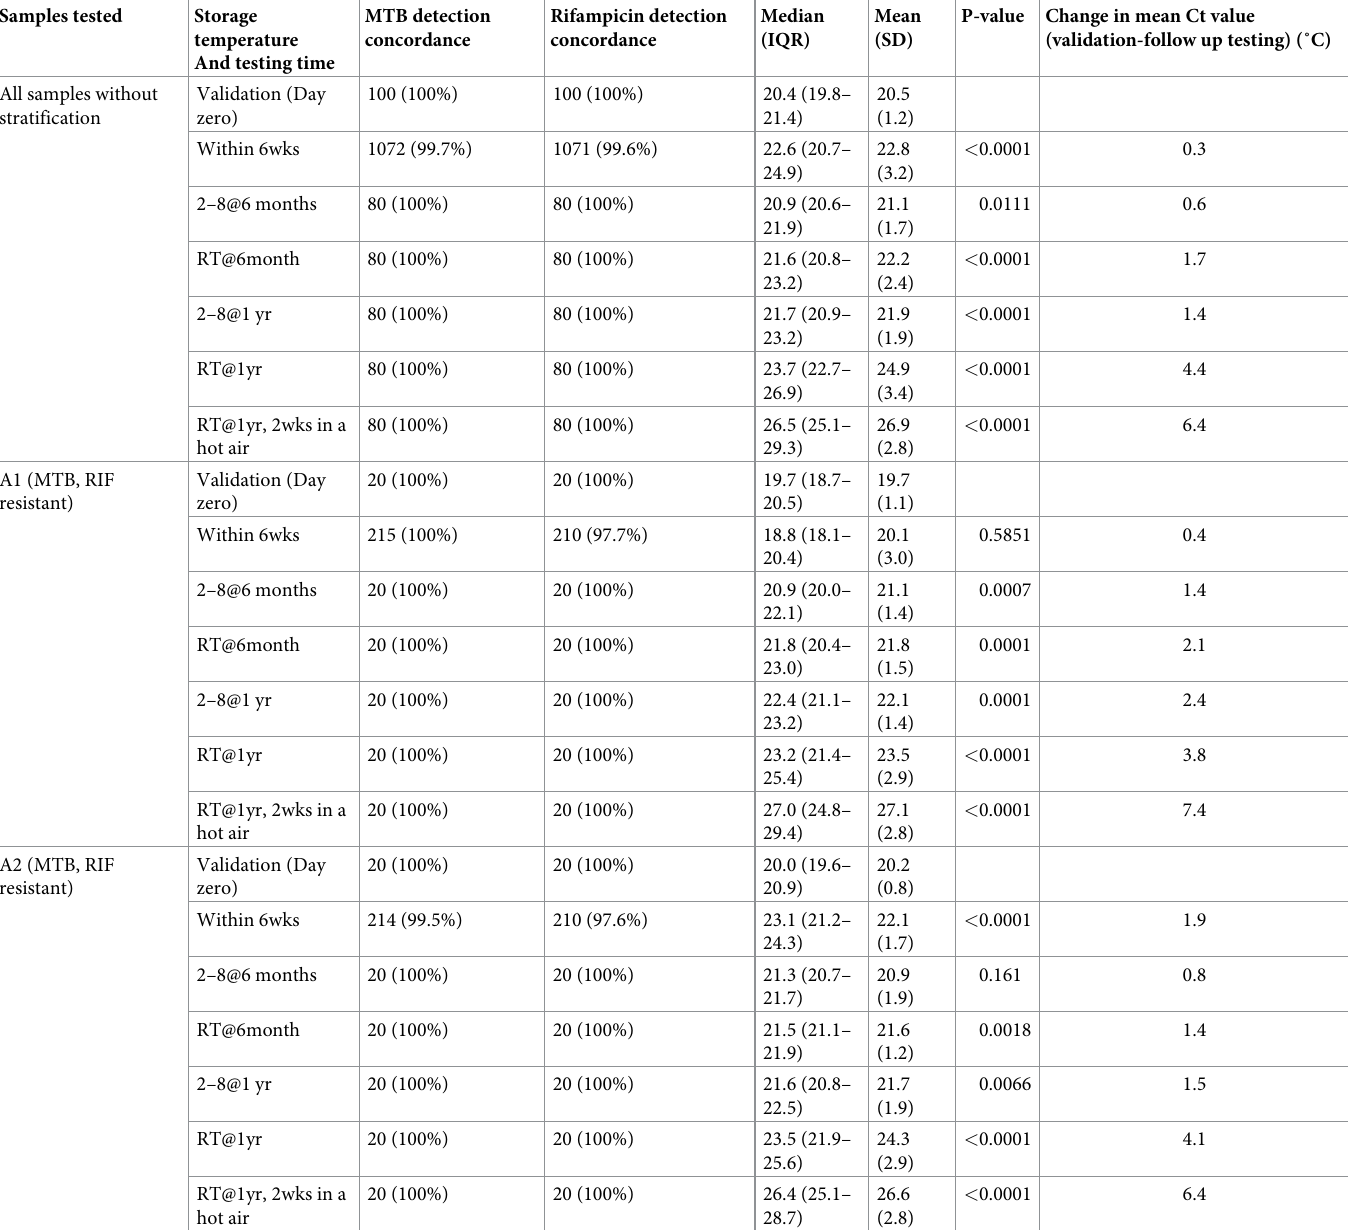
Table 4. Performance of DTS panels tested at different periods and storage temperatures. Samples